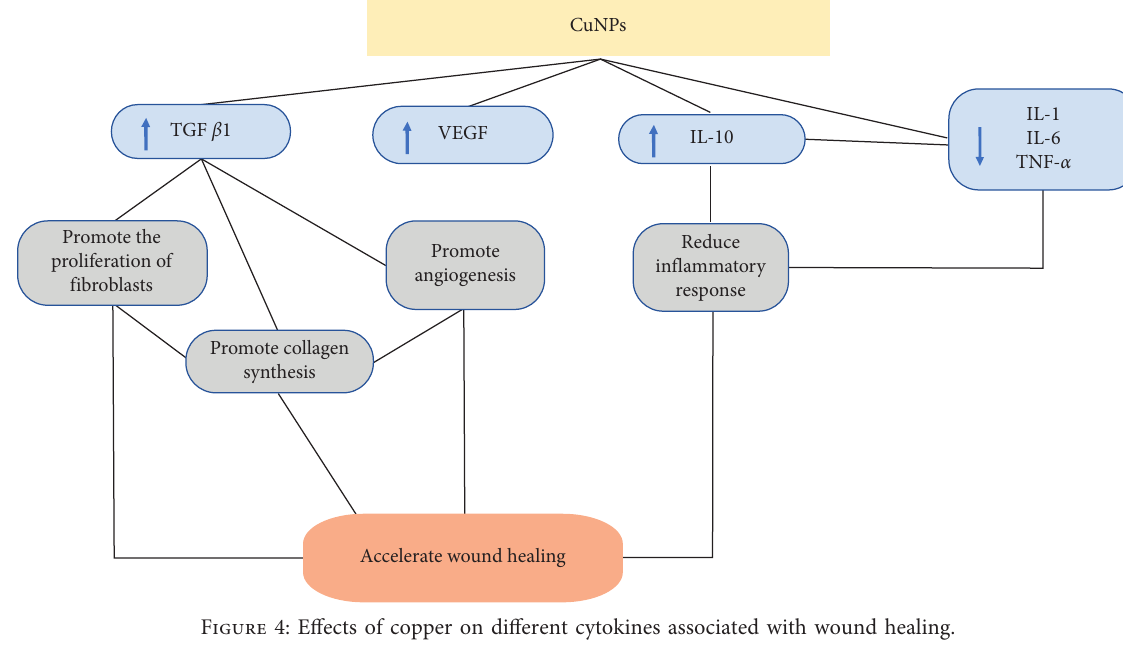
Figure 4: Effects of copper on different cytokines associated with wound healing.